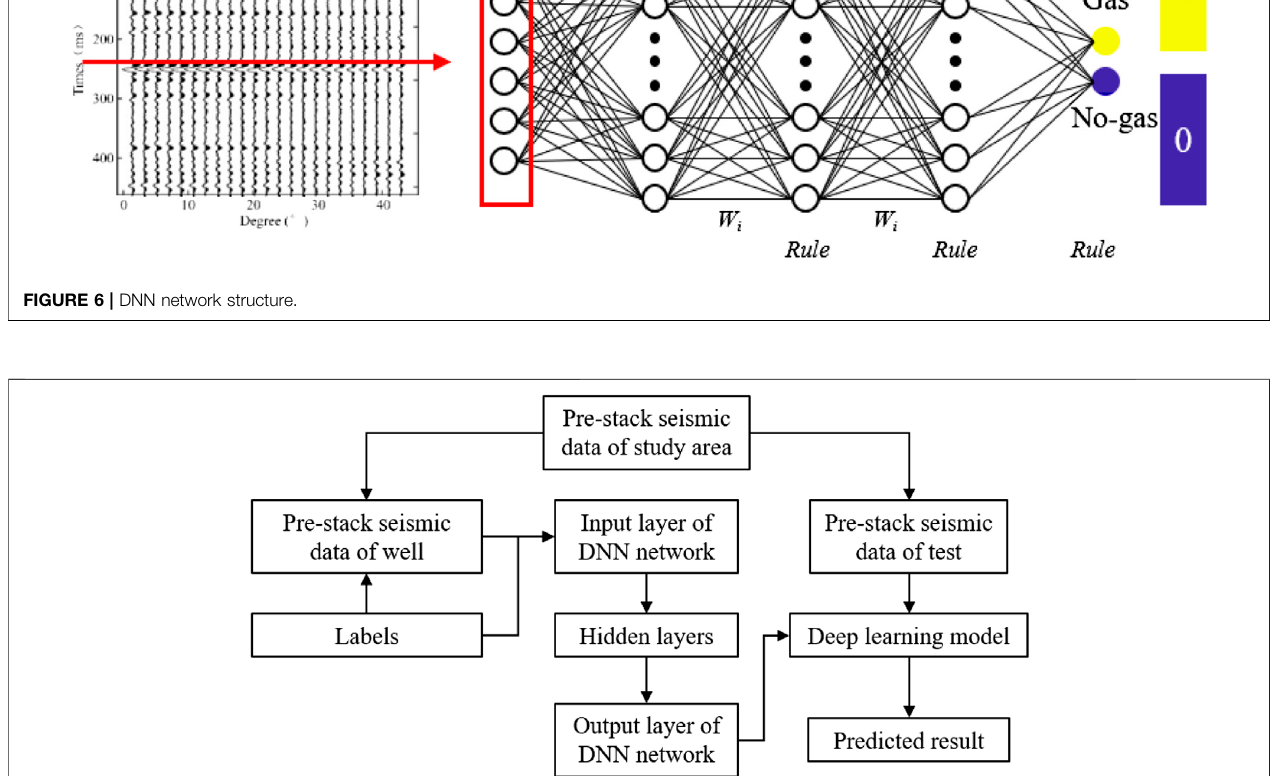
FIGURE 7 | Flow chart of DNN hydrocarbon detection